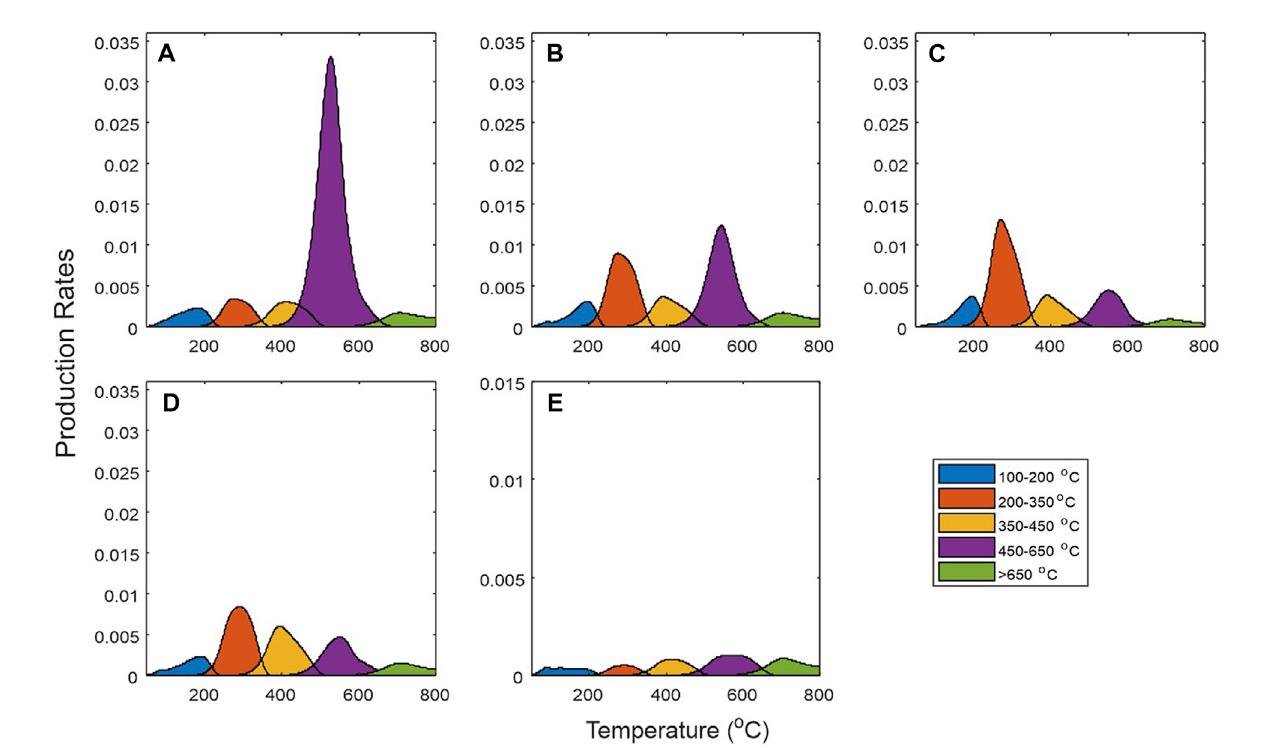
FIGURE 11 Petroleumandkerogencomponentgroupingforthe fi veDuvernayshalesamples,showingprogressivedecreaseinkerogencomponentandincreasein petroleum components with increasing thermal maturity: (A – E) corresponding to samples C-590392, C-594351, C-590327, C-590436 and C-590378 in Table 1. Petroleum components are lost in gas generation windows due to hydrocarbon expulsion and evaporative loss of gaseous